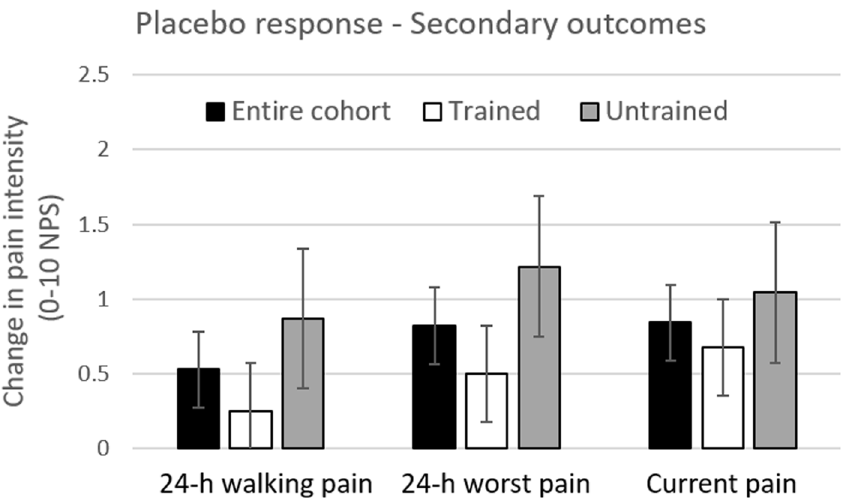
Fig 5. The placebo response in the entire cohort, trained and untrained subjects—Secondary outcome measures. Change in placebo was calculated as difference between pain scores in the placebo arm (pre-minus post treatment). Black bars represent changes in pain in the entire cohort. White and Black bars represent changes in pain in the trained (n = 28) and untrained (n = 23) sub-cohorts, respectively. Error bars are Standard Error of the Mean